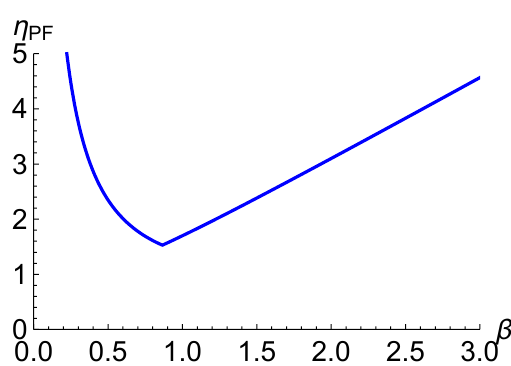
Figure 4. Perron–Frobenius eigenvalue of H β , which exists when µ > 0. Parameters used are D e = 0.3, D d = 1.5, r e = 1.1, r d = 0.2, e = 0.001, d = 0.00025, µ =